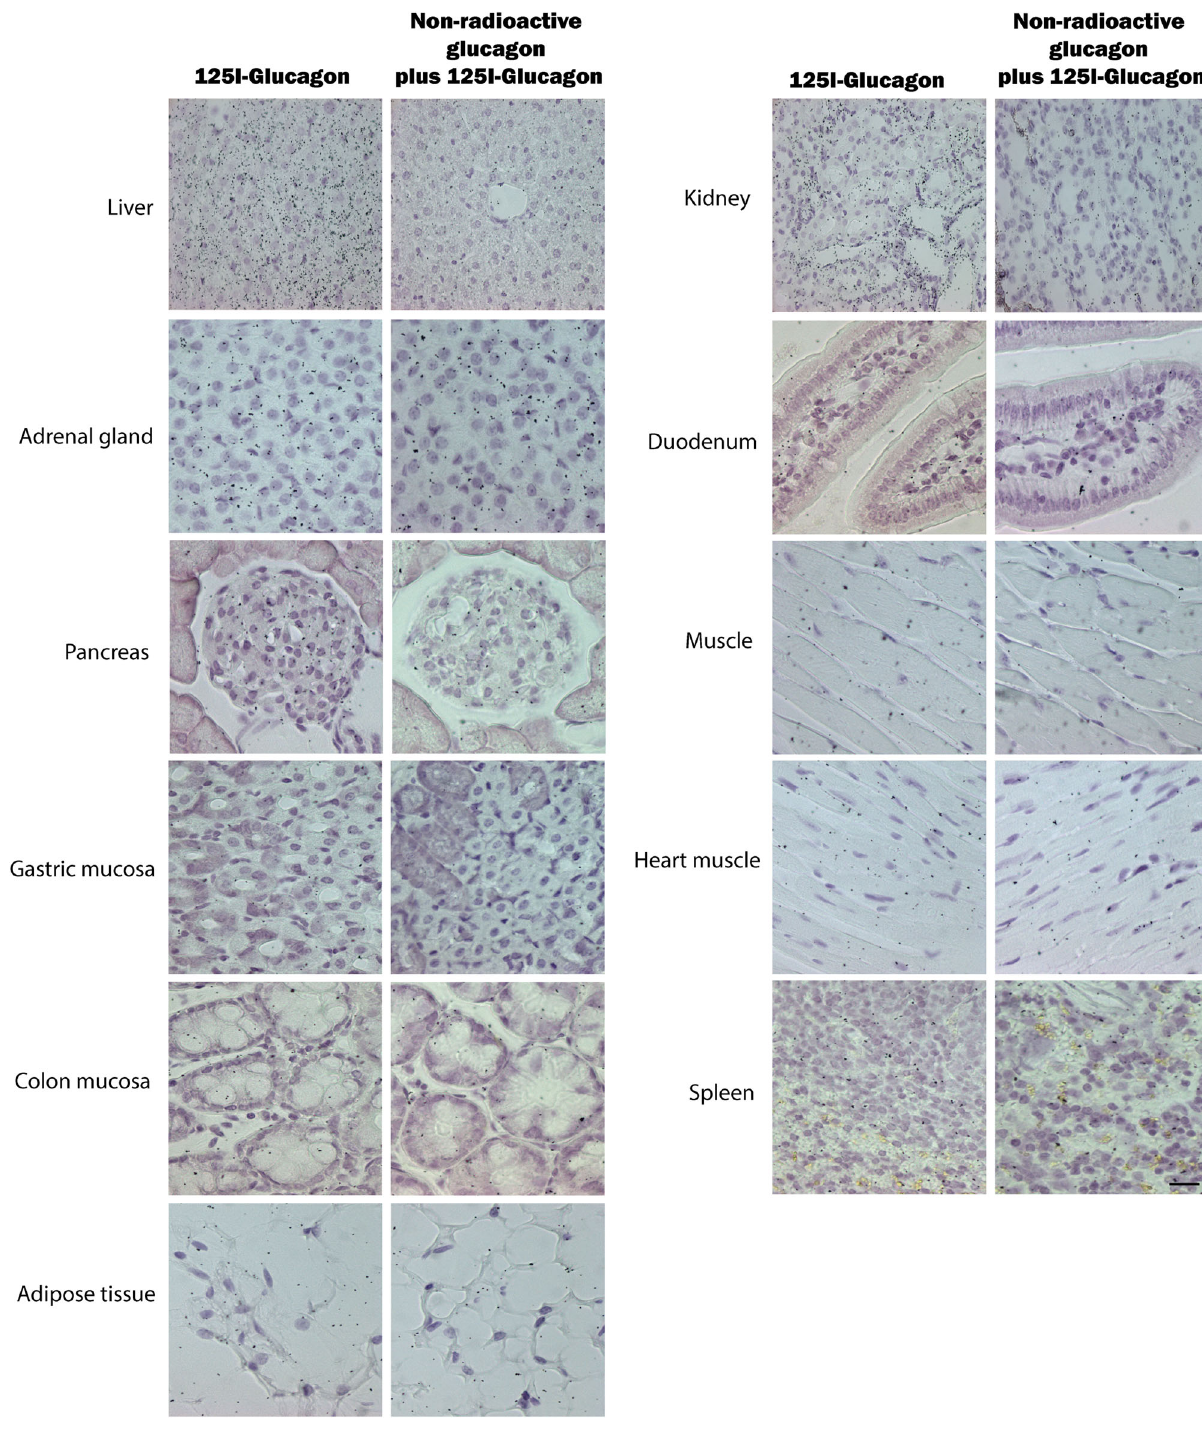
Fig. 4 Comparison of glucagon receptor expression by antibody and antibody-independent approaches. Microphotographs of the liver, kidney, adrenal gland, duodenum, pancreas, muscle tissue, gastric mucosa, heart, colon mucosa, spleen, and adipose tissue of female C57BL/6JRj mice, 13 weeks of age, that received an intravenous injection of 3 pmol 125 I-Glucagon or 5 nmol of non-radioactive glucagon in combination with 3 pmol of 125 I-Glucagon to test for speci fi c binding. Autoradiography of mouse liver, kidney and pancreas showed high density of grains in the tissue, which was attenuated in mice receiving both labelled and non-labelled glucagon. Liver, adrenal gland, pancreas, gastric mucosa, colon mucosa, and fat tissue, X100, scale bar = 50 µ m. Kidney, duodenum, muscle, heart muscle, and spleen, X70, scale bar = 70 µ m. antibody-based approach in combination with two non-antibody- were observed in the liver, heart muscle fi bers, kidney tubuli based approaches: autoradiography and data analysis from RNA- (distal tubuli), the islets Langerhans in the pancreas, pre- sequencing data. Using IHC, various mouse tissues were exam- adipocytes found in relation to kidney tissue and BAT. The ined for GCGR expression. The most intense immunostainings speci fi c GCGR localization in some of these different tissues has COMMUNICATIONS BIOLOGY| (2022) 5:1278